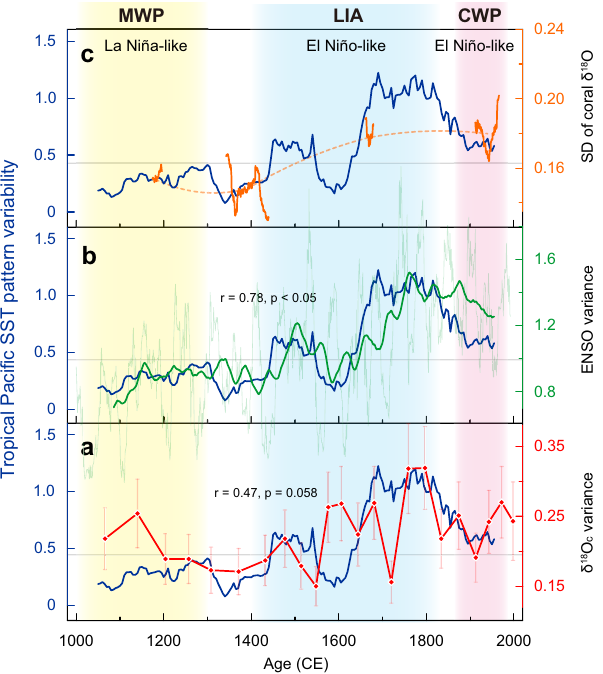
Fig. 5 Comparison of records of the tropical Paci fi c variability. The tropical Paci fi c SST pattern variance in this study is shown by the dark blue line in each panel. a δ 18 O c variance from planktonic foraminifera in ocean sediment core KNR195-5 MC42C in the eastern equatorial Paci fi c (red) 14 . b ENSO variance record from the North American Drought Atlas (75-yr smoothing, green) 7 . c The standard deviation (SD, 50-yr sliding window, an indicator of variability on the interdecadal timescale) of coral δ 18 O values from Palmyra Island (orange) 9 . The yellow shading indicates the MWP, the blue shading indicates the LIA, and the red shading indicates the